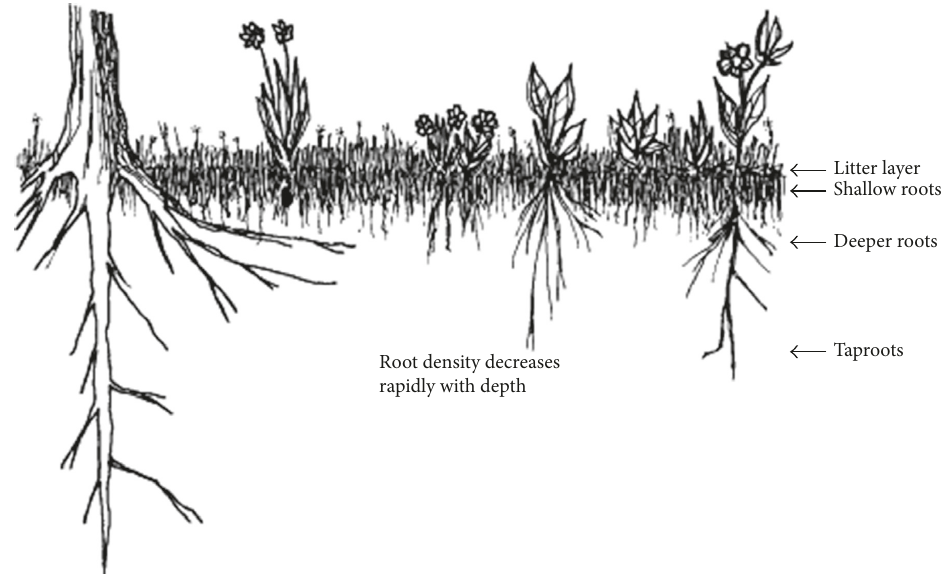
Figure 5: Root system in the soil.